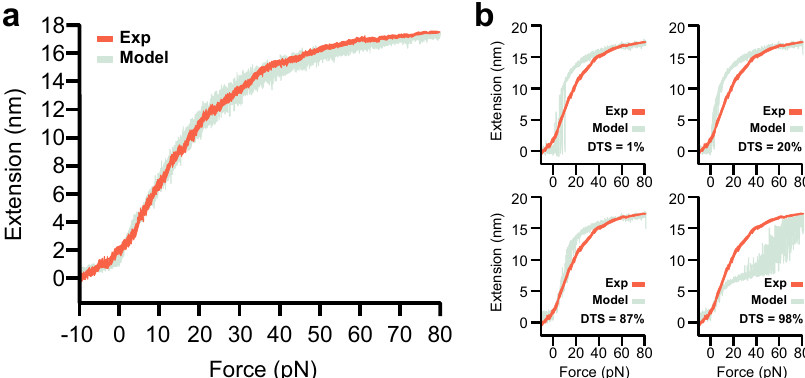
Fig. 4 Data analysis using the Bell model. a Force-extension plot from a simulation using the numerical Bell model with stochastic transitions (light green). Average experimental traces were obtained at 1 pN/s (orange). b Same Bell model are shown in (green) using different transition state distances and the average experimental traces are superimposed